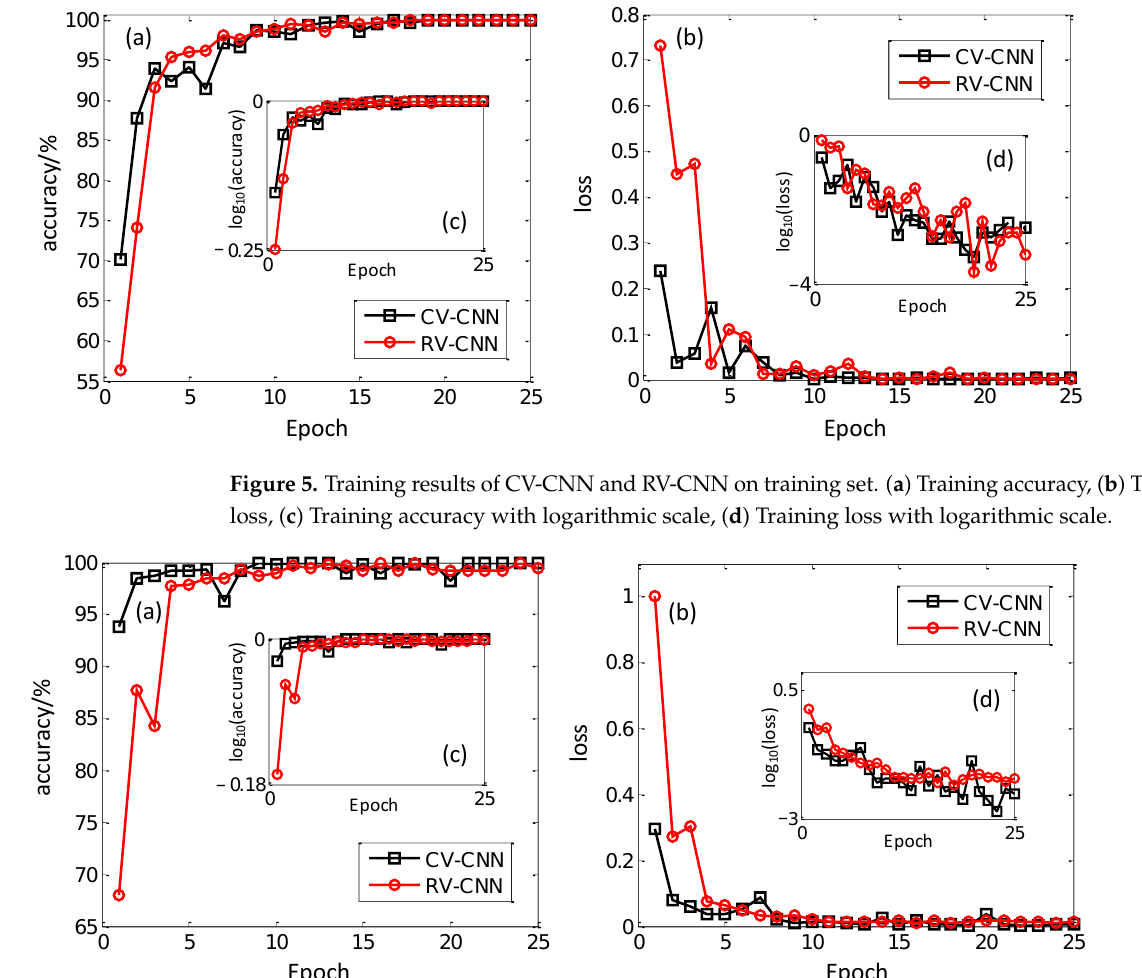
Figure 6. Validation results of CV-CNN and RV-CNN on validation set. ( a ) Validation accuracy, ( b ) Validation loss, ( c ) Validation accuracy with logarithmic scale, ( d ) Validation loss with logarithmic scale.